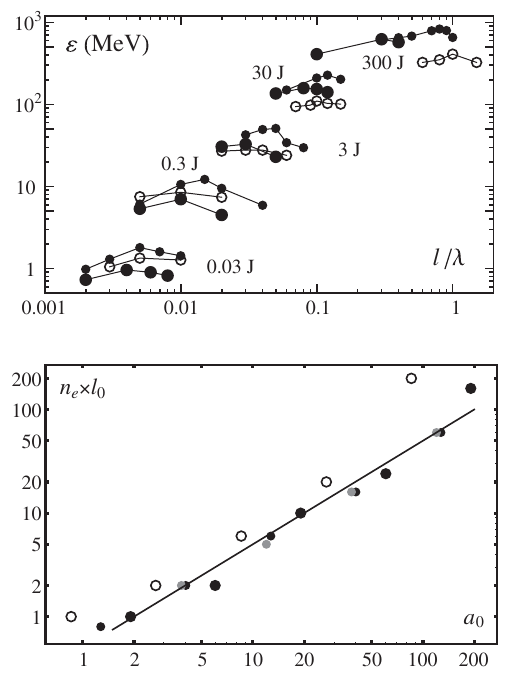
FIG. 1. Maximum proton energy vs target thickness for differ- ent laser energies (top panel) and optimum target areal density in n λ units vs laser field a c × 0 (bottom panel). For both panels large black dots stand for τ ¼ 30 fs and d ¼ 4 μ m, small black dots for τ ¼ 30 fs and d ¼ 6 μ m, gray dots (only for the bottom panel because gray dots are indistinguishable from the large black dots in the upper panel) for τ ¼ 30 fs and d ¼ 2 μ m, and open circles for τ ¼ 150 fs and d ¼ 4 μ